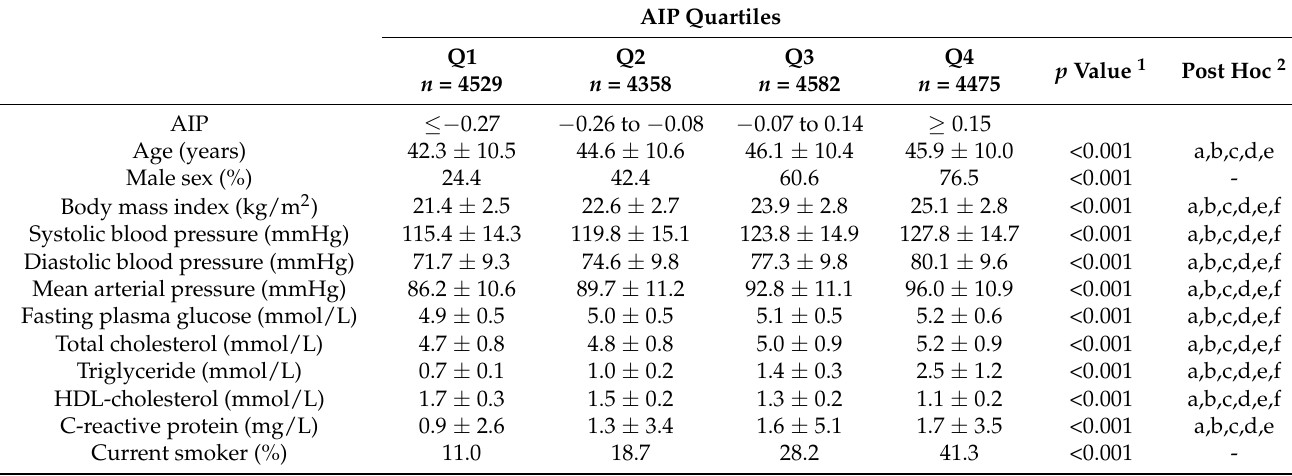
Table 1. Baseline characteristics of the study population according to the atherogenic index of plasma (AIP)